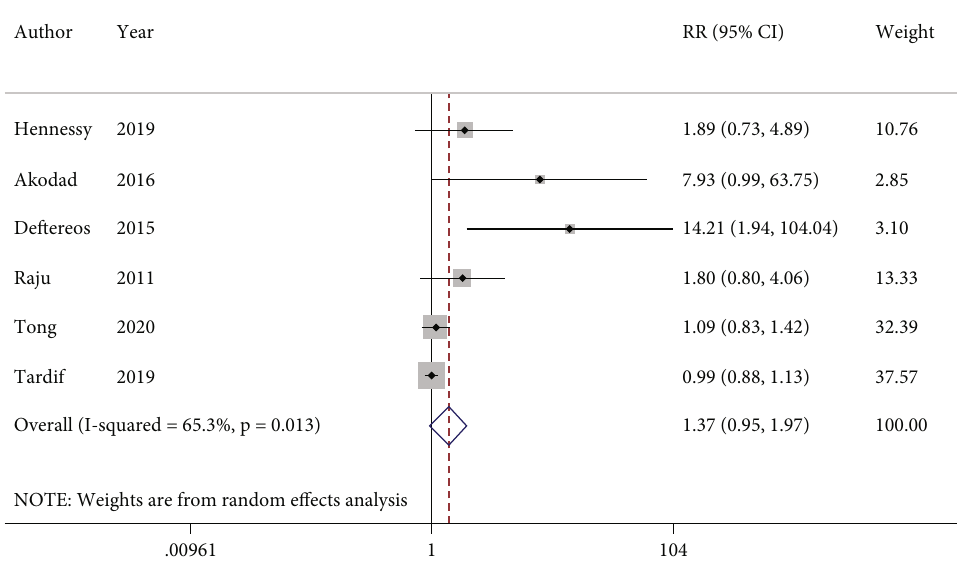
Figure 6: Forest plot displaying risk ratio and 95% con fi dence intervals for the impact of colchicine on gastrointestinal adverse events in patients with acute coronary syndrome. RR: risk ratio; CI: con fi dence